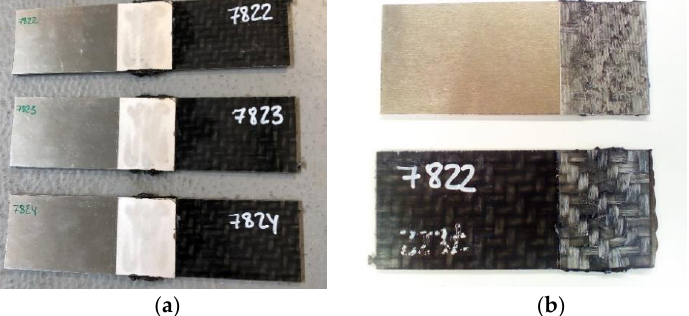
Figure 7. ( a ) Specimens joined at 370 °C, 50 mm/s, 3.5 bar, and 2 tracks. ( b ) The same specimen after lap shear test.